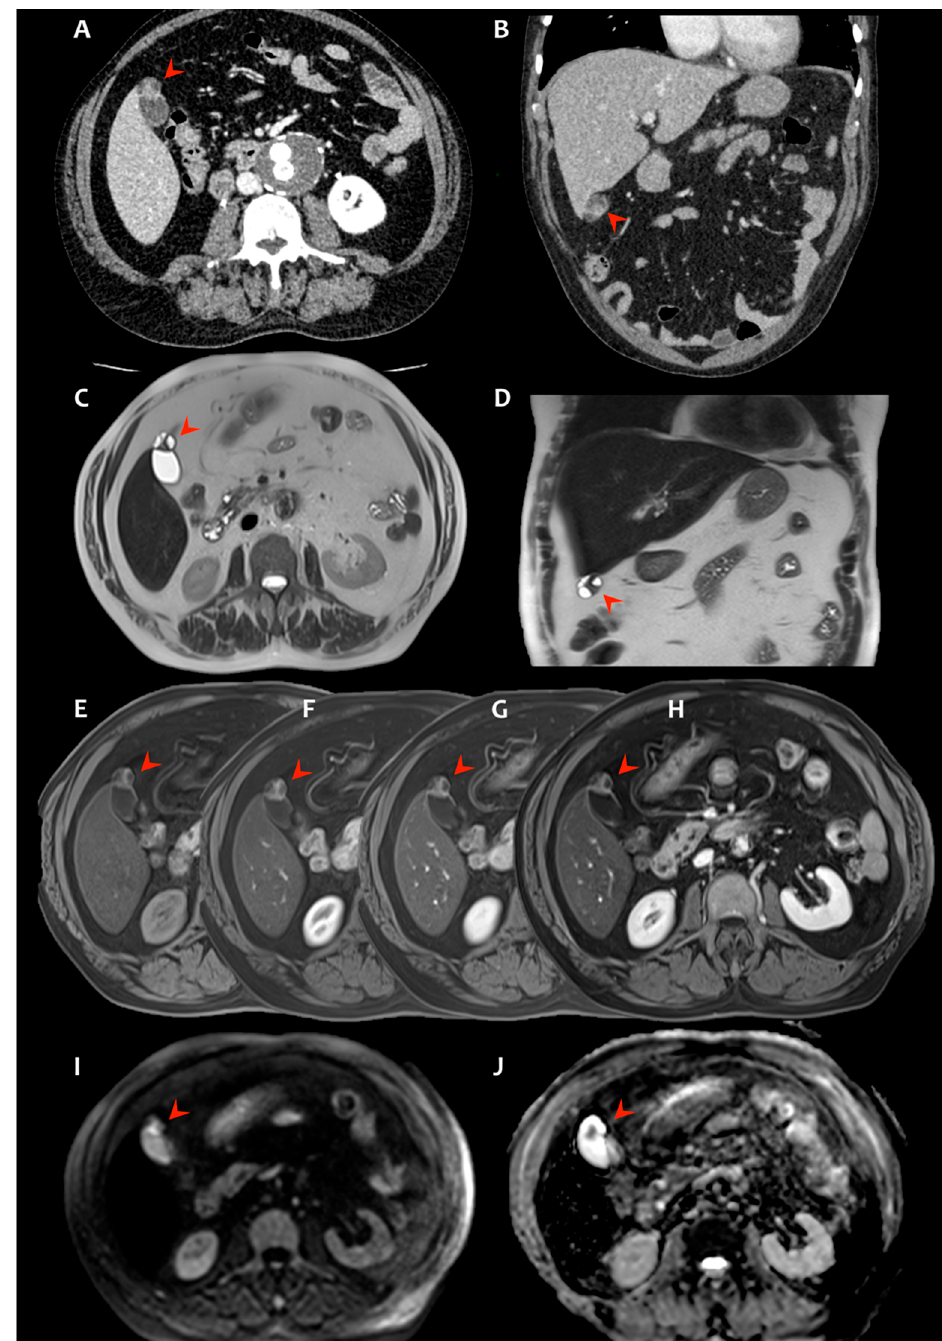
Figure 1. Imaging features of case #1, demonstrating fundal cystic spaces with a solid endoluminal tissue component (red arrowheads), representing a thickened cyst wall or a septum. The tissue shows: inhomogeneous enhancement in portal-phase CECT ( A , B ); T2-weighted MRI hypointensity ( C , D ); T1-weighted MRI spontaneous hyperintensity ( E ) with early contrast enhancement in arterial-phase ( F ) and with no wash-out in portal- ( G ) or late- ( H ) phases; MR-DWI restriction ( I ) with corresponding ADC hypointensity ( J ). ADC values = mean 1.43 × 10 − 3 mm 2 /s, range 1.35–1.50. Histopathology: intracholecystic papillary neoplasia (ICPN) involving areas of pre-existing adenomyomatosis (ADM) with Rokitansky-Aschoff sinuses (RAS).